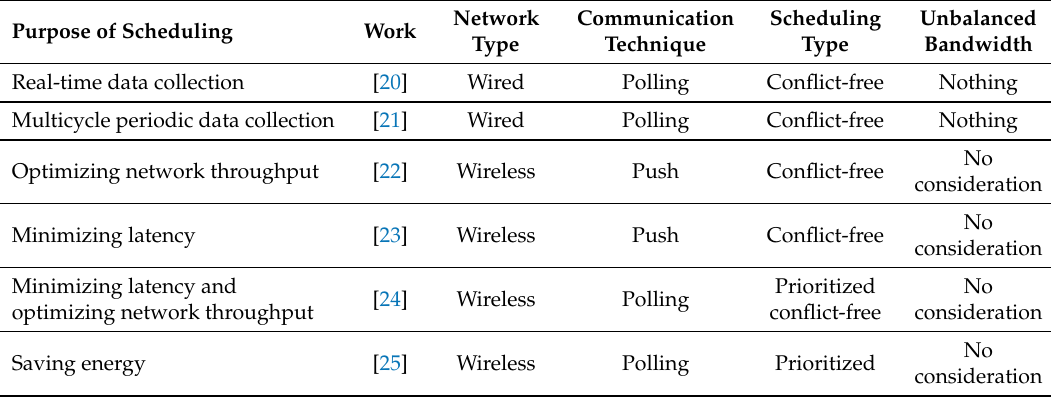
Table 1. Summary of related work in comparison with our